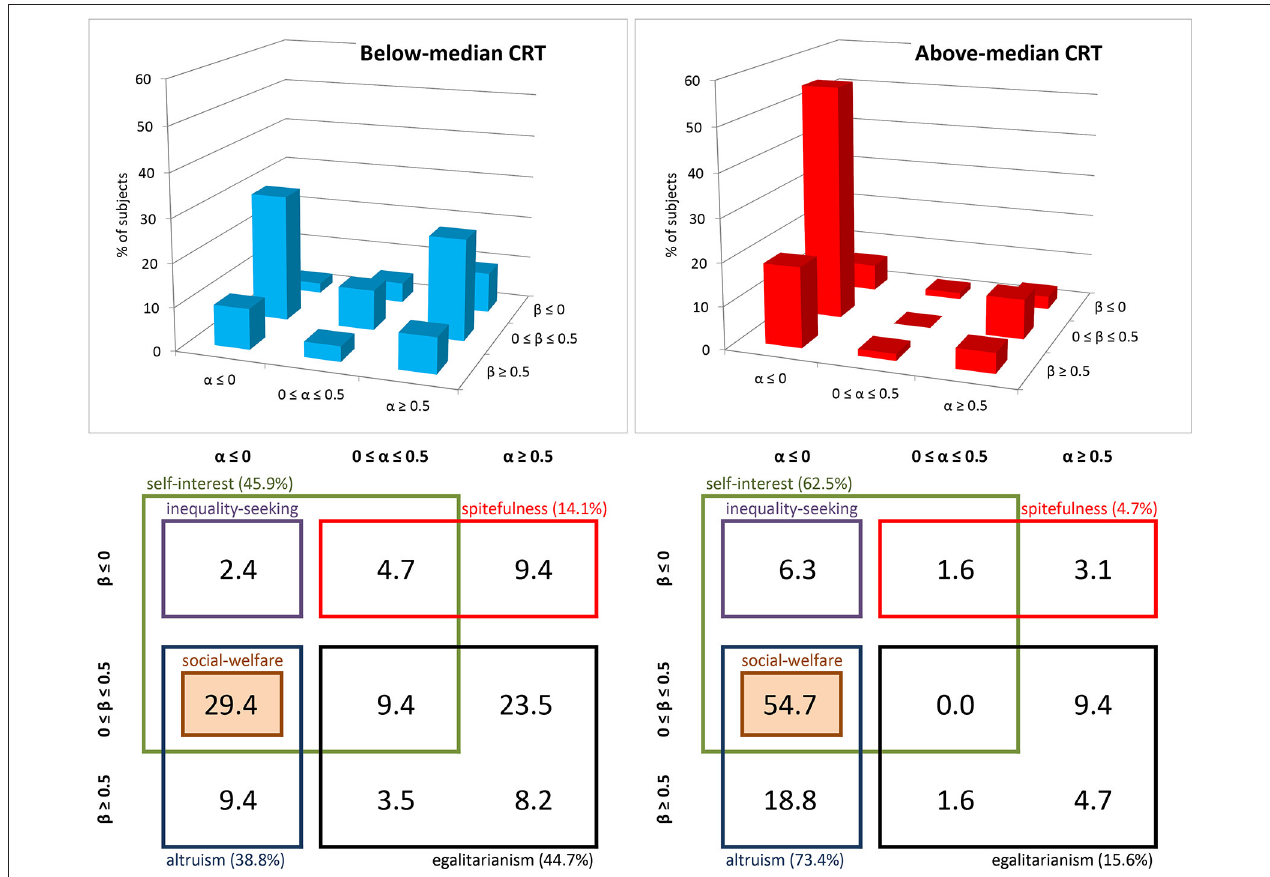
FIGURE 2 | Classification of subjects according to the envy and compassion parameters, by CRT groups (Study 1). The figure displays the % of subjects that can be classified according to each combination of α and β and the social preferences which are consistent with each category, broken down into below-median ( n = 85 ) and above-median ( n = 64 ) CRT score